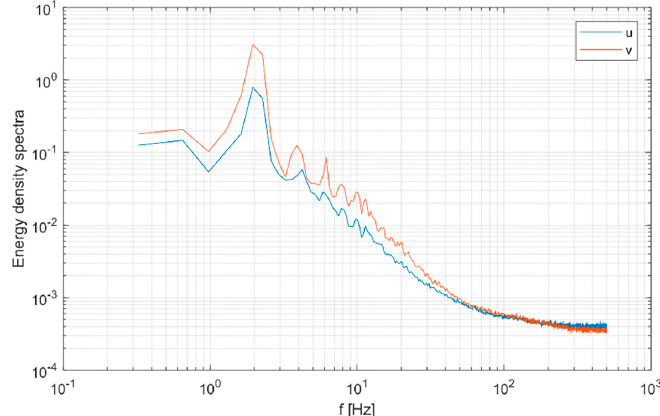
Figure 5. Field averaged spectral energy density for measured velocity components.